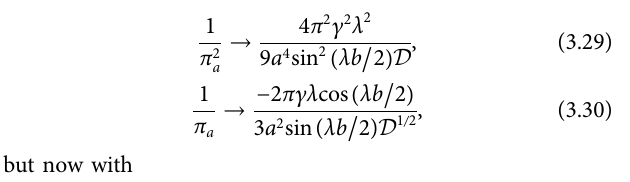
FIGURE 5 | Schematic plot of λ 2 H de fi ned by Eq. 3.25 vs. t for mLQC-I in the dressed metricapproachforthe quadratic and theStarobinskypotentials, where a ’’ ( t H ) (cid:2) 0 and a ’’ ( t i ) (cid:2) 0 with t i being the starting time of the in fl ationary phase. During the slow-roll in fl ation, we have λ 2 H ≈ L 2 H / 2. In the contracting phase t < t B , the universe is initially de Sitter and we still have λ 2 ≈ L 2 / 2, but now it increases exponentially toward bounce t → t H H universe in this phase is exponentially contracting. However, several Planck seconds before the bounce, the universe enters a non-de Sitter state, during which λ 2 H starts to decrease until the bounce. The qualitative behavior of the comoving Hubble radius is the same for the quadratic and the Starobinsky potentials. Different potentials will change the values of t H and t i